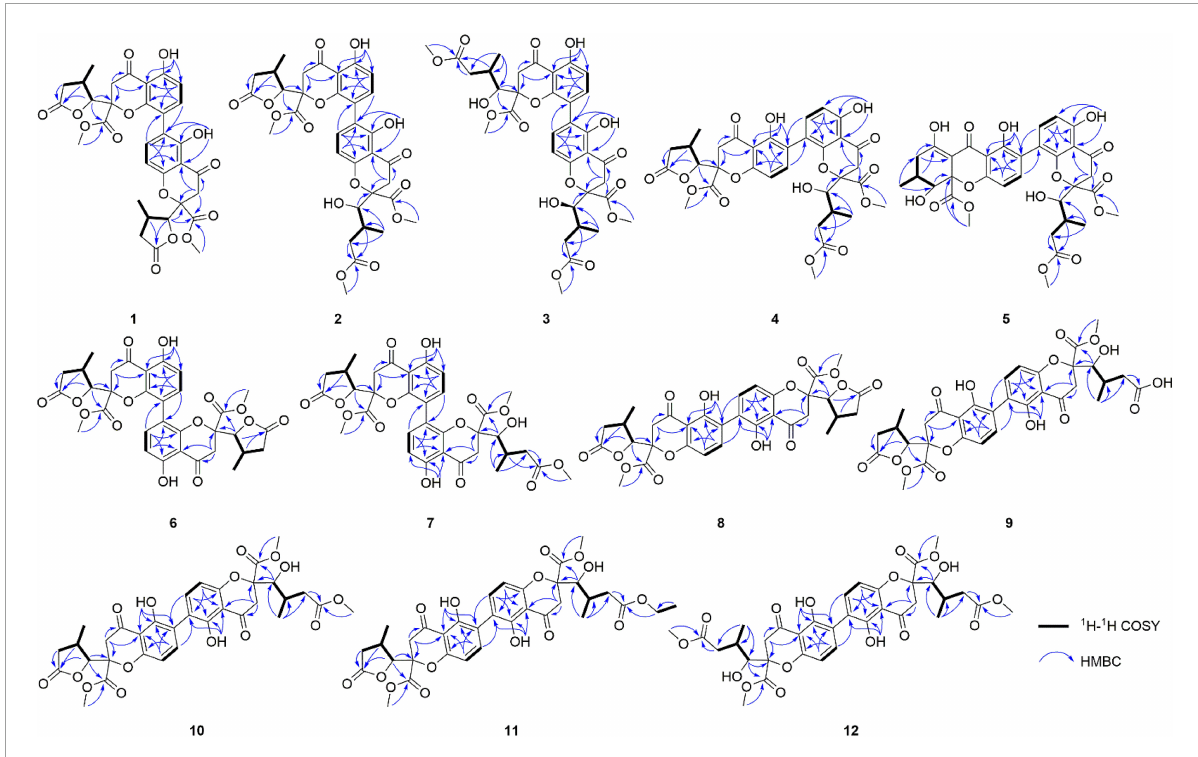
FIGURE2 Key 1 H- 1 H COSY and HMBC correlations for 1 – 12